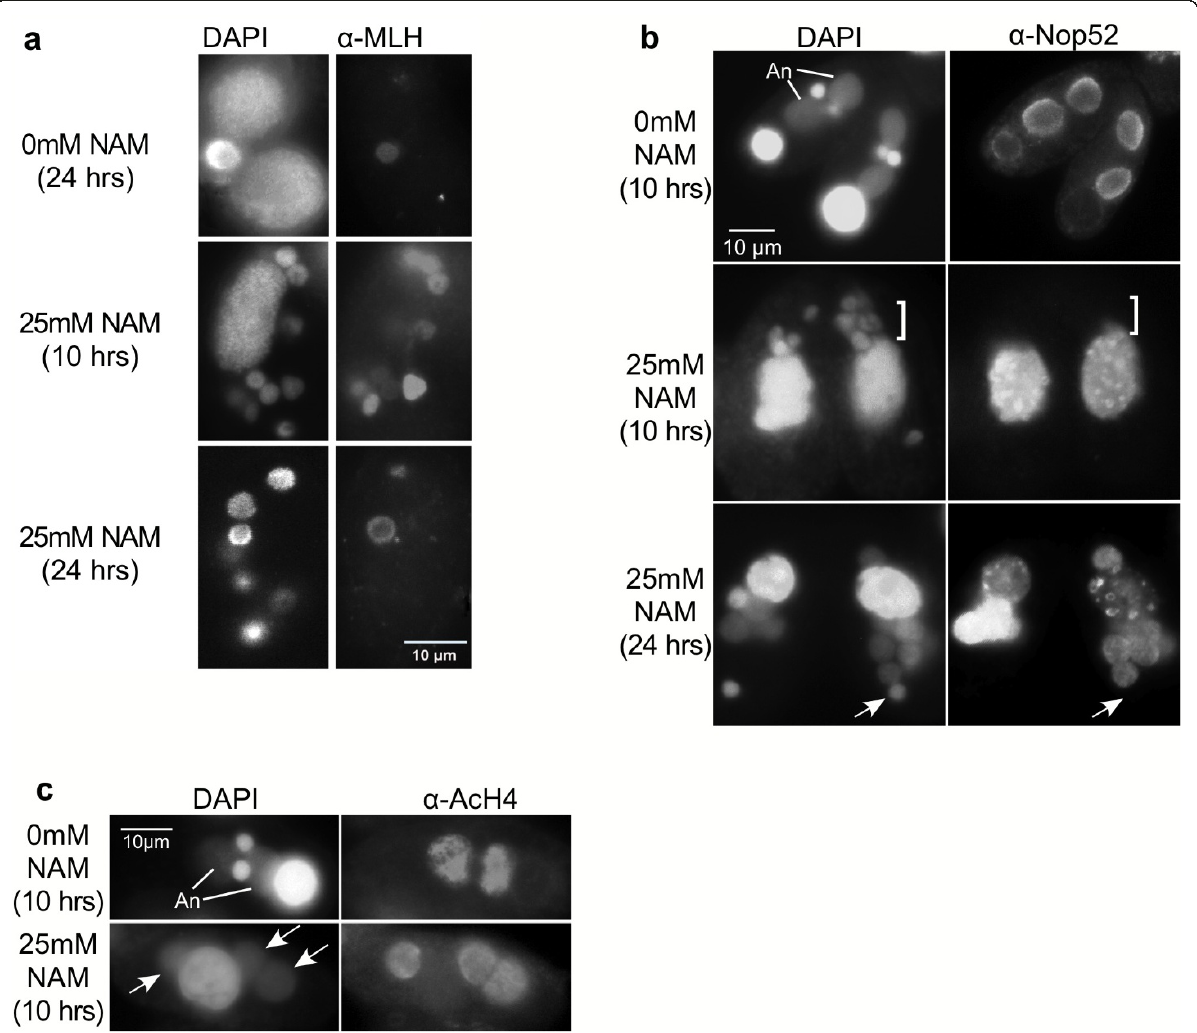
Figure 2 Extra nuclei in NAM-treated cells acquire new macronucleus characteristics . Cells were mixed in the absence (0 mM NAM) or presence (25 mM NAM) of nicotinamide and fixed with 2% paraformaldehyde at either 10 or 24 hrs into conjugation (post-mixing). Fixed cells were subjected to immunoblot analysis with a a -MLH (micronuclear linker histone; note that for the 24 hr NAM-treated sample a cell with an unusual a -MLH-positive micronucleus is shown for signal comparison), b a -Nop52 (brackets and arrows indicate examples of nuclear bodies that do not bind a -Nop52; “ An ” , anlagen), or c a -acetylated H4 ( a -AcH4) antisera (arrows indicate nuclear bodies that bind a -AcH4). All fixed cells were counterstained with